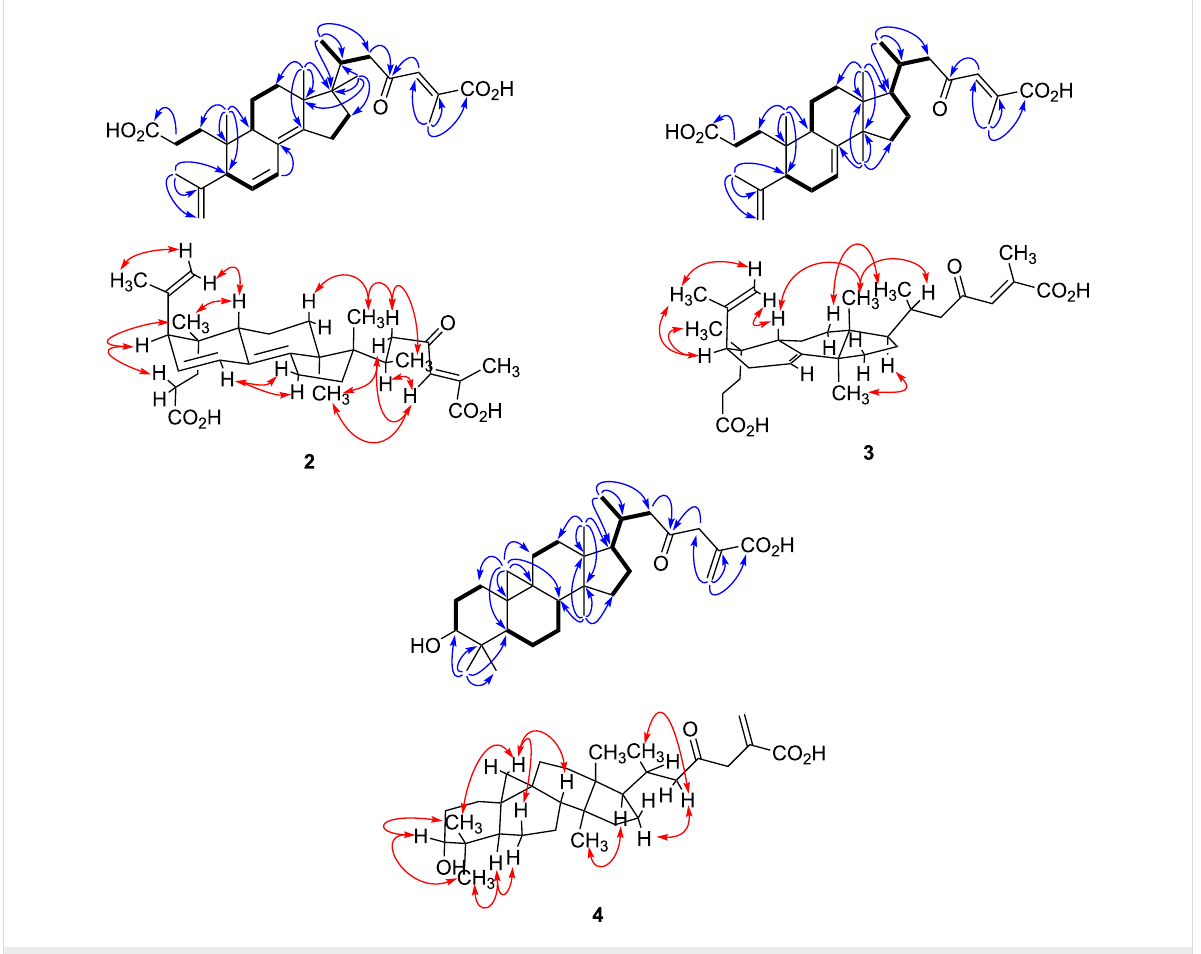
Figure 2: Selected COSY ( ▬ ), HMBC (blue arrows) and NOESY (red arrows) correlations for compounds 2 – 4 .